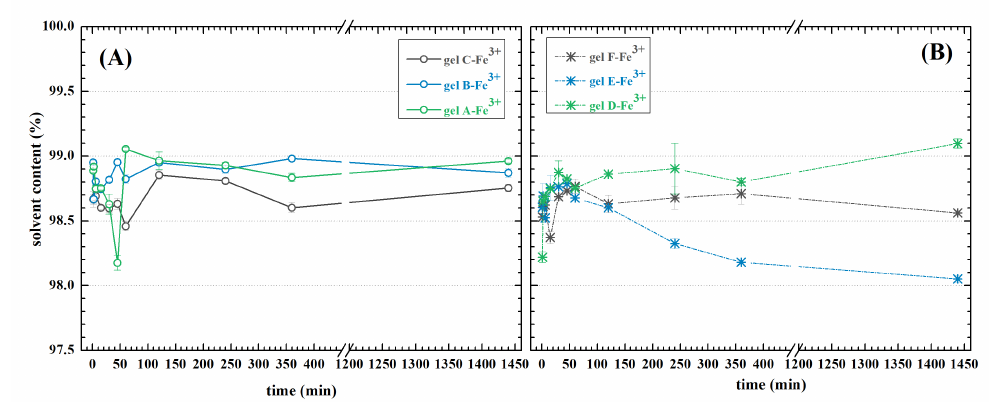
Figure 9. Swelling of dually cross-linked hydrogels. ( A ) Hydrogels based on HA-ADH modified using EDC; ( B ) Hydrogels based on HA-ADH modified using DMTMM.